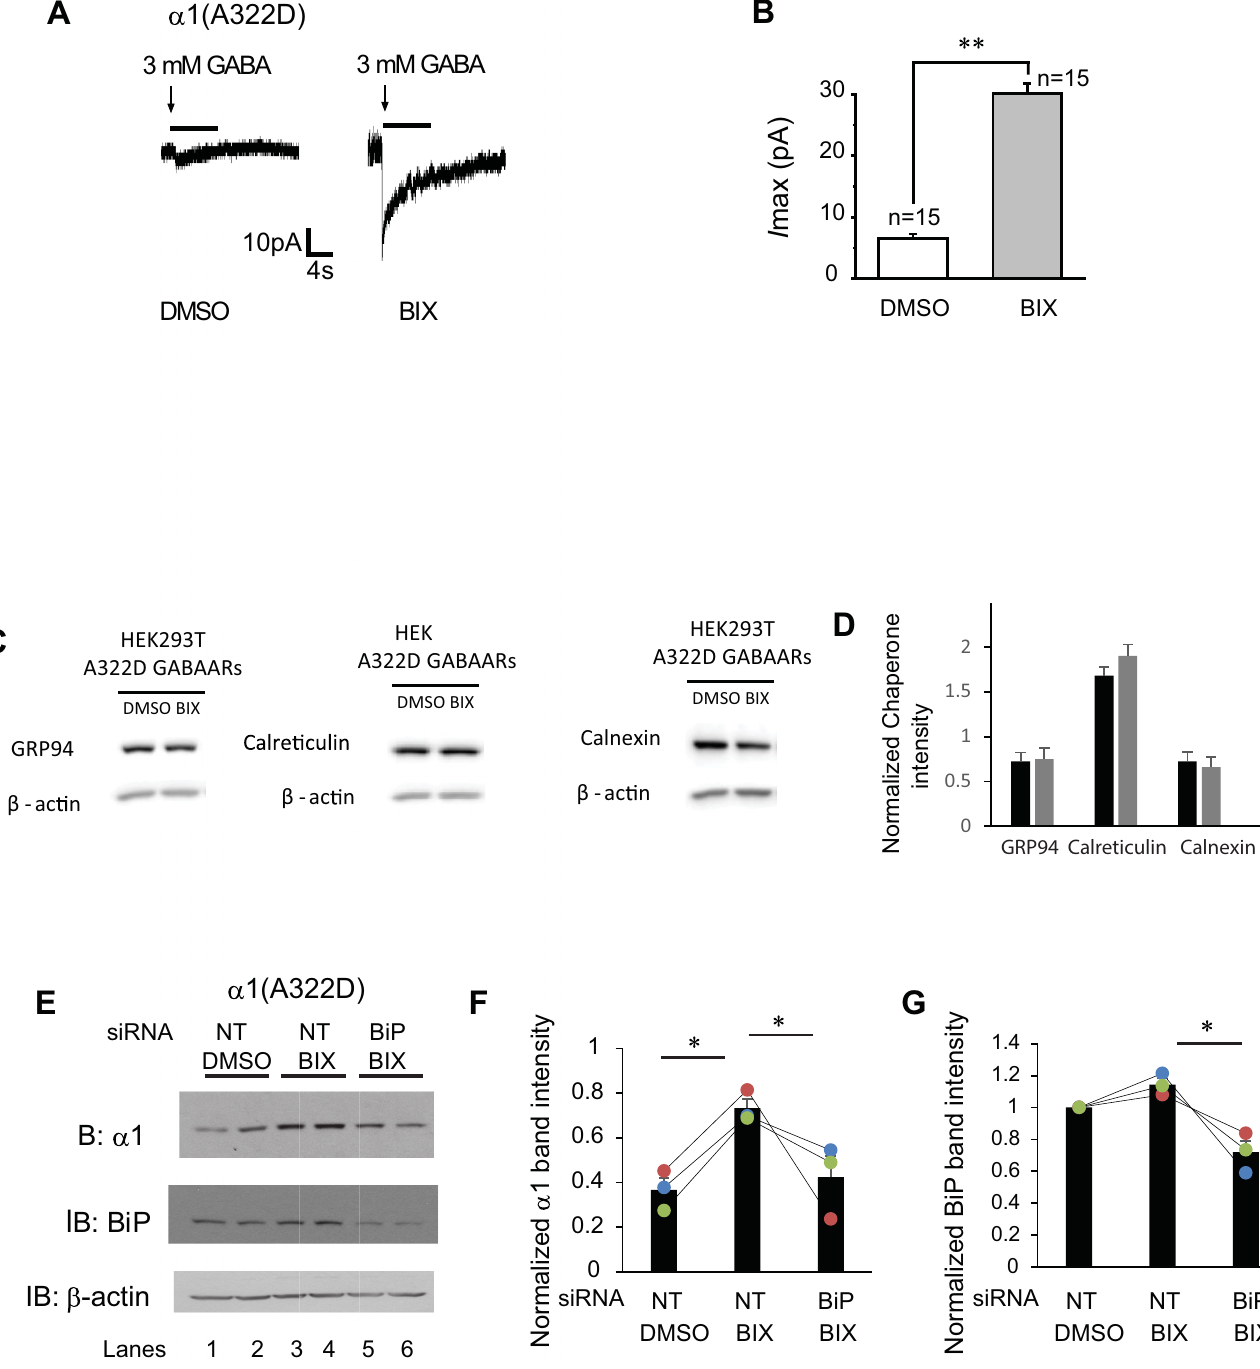
Fig 4. BIX enhances the function of α 1(A322D) β 2 γ 2receptors. ( A ) Representative whole-cell patch clamping recording traces in monoclonal HEK293T cells stably expressing α 1(A322D) β 2 γ 2 GABA A receptors. Cells were treated with BIX (12 μ M, 24h) or DMSO before voltage clamping. GABA (3mM) was applied to induce chloride currents with a holding potential of -60 mV. Quantification of the peak currents ( I max) is shown in ( B ). The number of patched cells in each group is shown on the top of the bar. pA: picoampere. ( C and D ) HEK293T cells expressing α 1(A322D) β 2 γ 2 receptors were treated with BIX (12 μ M, 24h). The cell lysates were then subjected to SDS-PAGE and Western blot analysis using corresponding antibodies ( C ). Quantification of normalized total cellular chaperone protein expression levels is shown in ( D ) (n = 4, paired t-test). ( E ) HEK293T cells stably expressing α 1(A322D) β 2 γ 2 receptors were treated with non-targeting (NT) or BiP siRNA for 48 hrs. Cells were then treated either with BIX (12 μ M) or DMSO vehicle control for another 24 hrs. Cells were then lysed and subjected to SDS-PAGE and western blot analysis. The quantitation results of α 1(A322D) and BiP are shown in ( F & G ) (n = 3, one-way ANOVA). � p < 0.05; �� p <